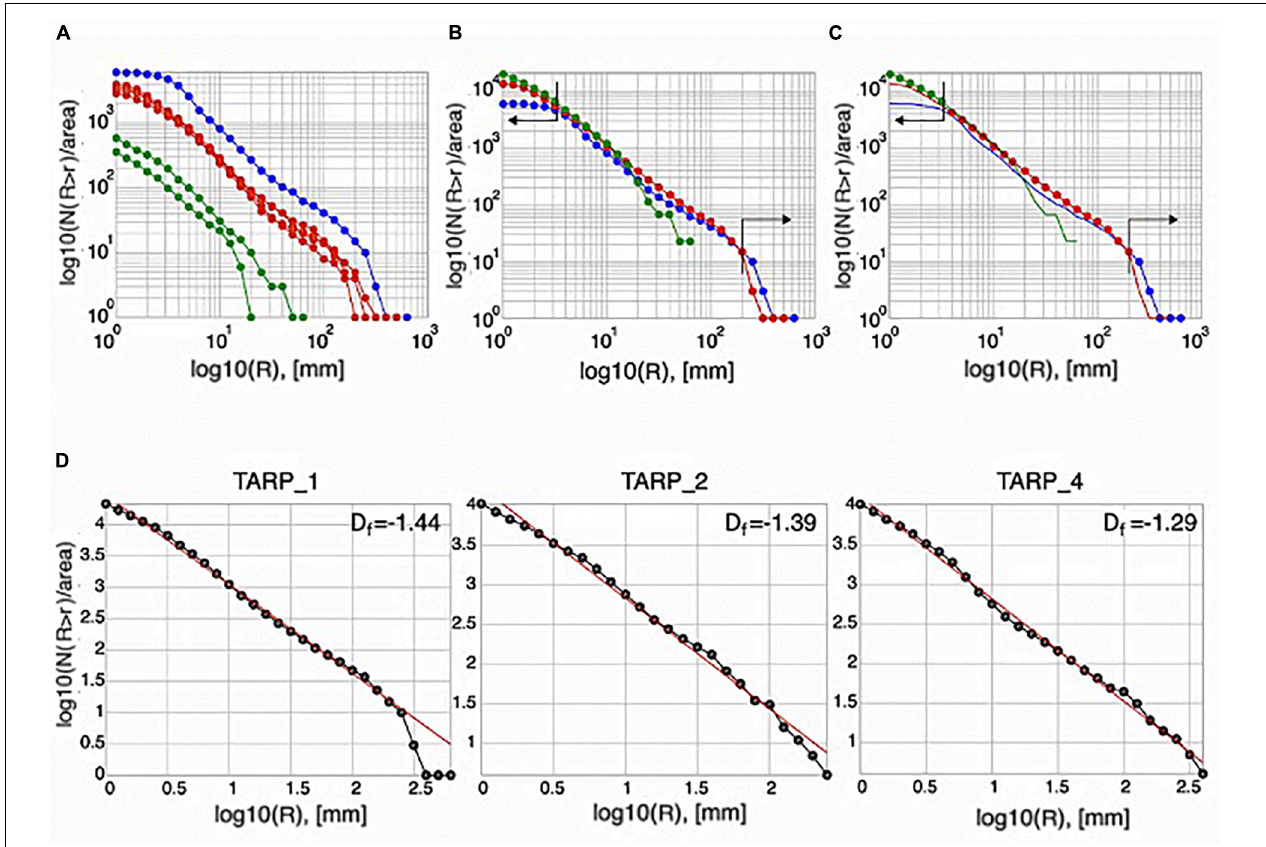
FIGURE 3 | (A) Cumulative fragment distributions for tarps 1, 2, and 4 for each magnification: the blue curve represents the lowest magnification used ( × 1), and the red curve relates to the intermediate magnification ( × 2), and the two green curves relate to the highest magnifications ( × 4 and × 5). (B) Distributions derived plotted as a single curve. The black arrows indicate the segment of the curves that have been considered for calculation of the final distribution. (C) The cumulative fragment distribution. (D) Fragment size distributions of each tarp and the associated fractal dimension ( D f ).